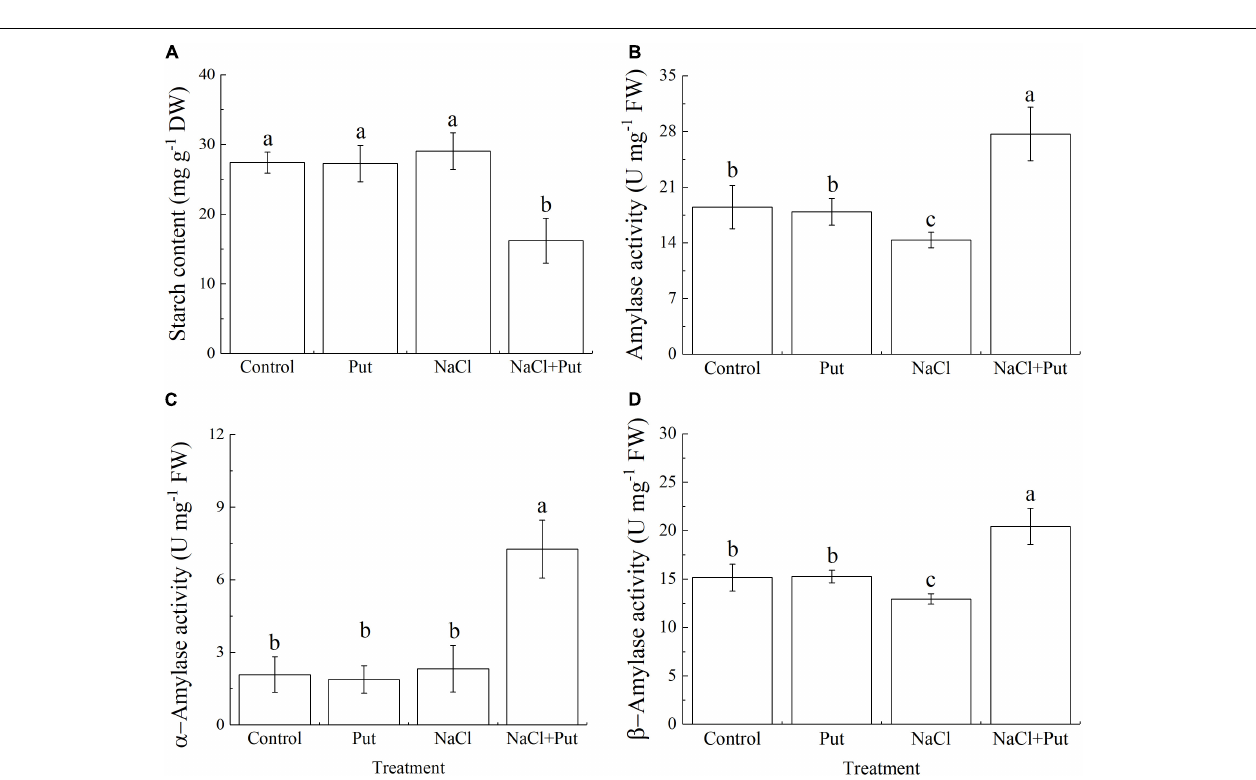
FIGURE 3 | Effects of seed soaking with Put or water on (A) starch content, (B) amylase activity, (C) α -amylase activity, or (D) β -amylase activity of white clover seedlings after 7 days of germination under normal condition and salt stress. Vertical bars above columns indicate the standard error of each mean ( n = 4). Different letters indicate a significant difference ( P ≤